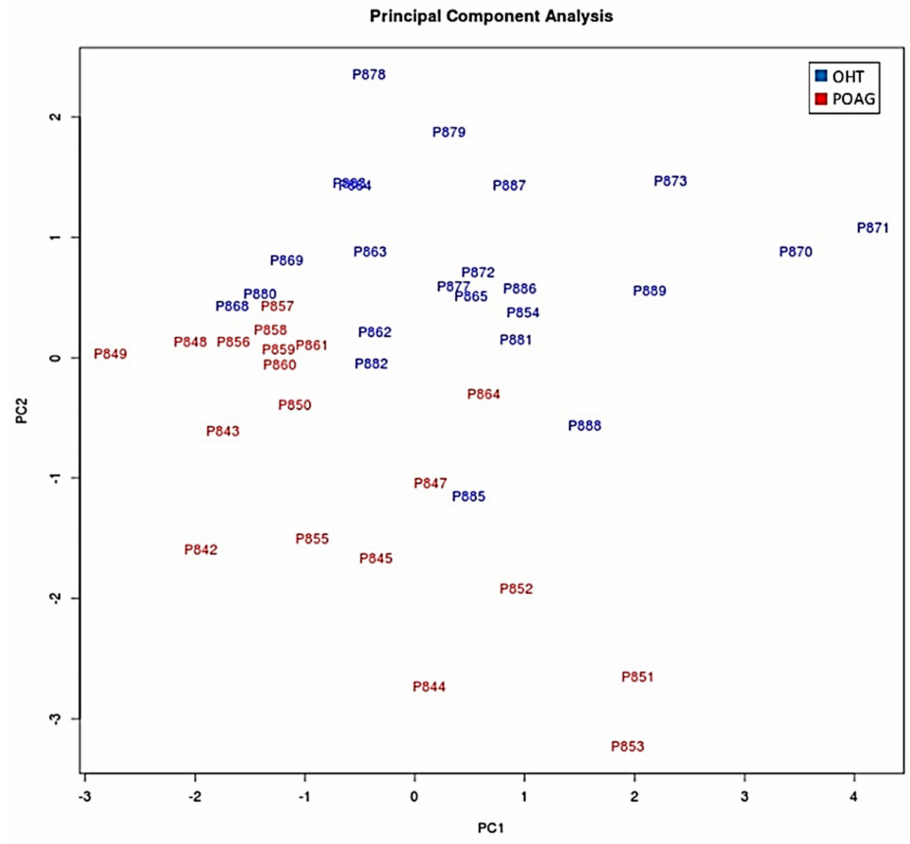
Figure 2. Principal component analysis (PCA) plot comparing the POAG and OHT groups using only miRNAs with statistically significant expression. Red: patients with OHT. Blue: patients with POAG. OHT: ocular hypertension/ocular hypertensives; POAG: primary open angle glaucoma.